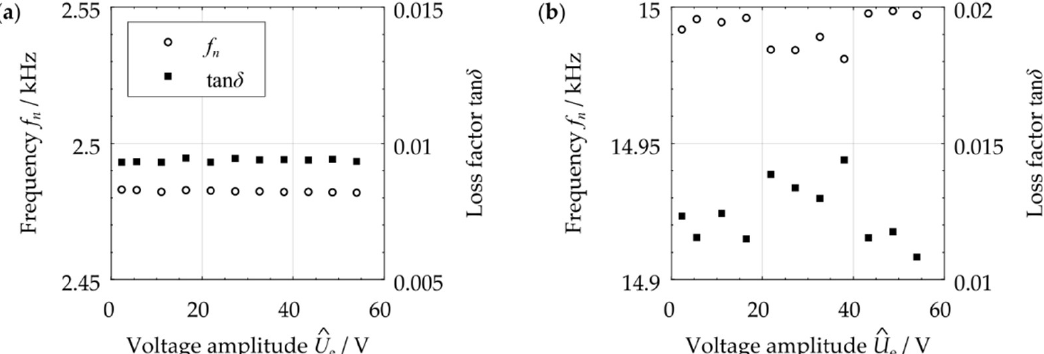
Figure 2. Influence of the actuator’s voltage amplitude ˆ U e on the specimen’s vibration behavior (evaluation of the average frequency spectra ˆ v 2 ( f ) , tightening torque M t = 1.1 Nm): ( a ) resonance at around 2.4 kHz, ( b ) resonance at around 15 kHz.